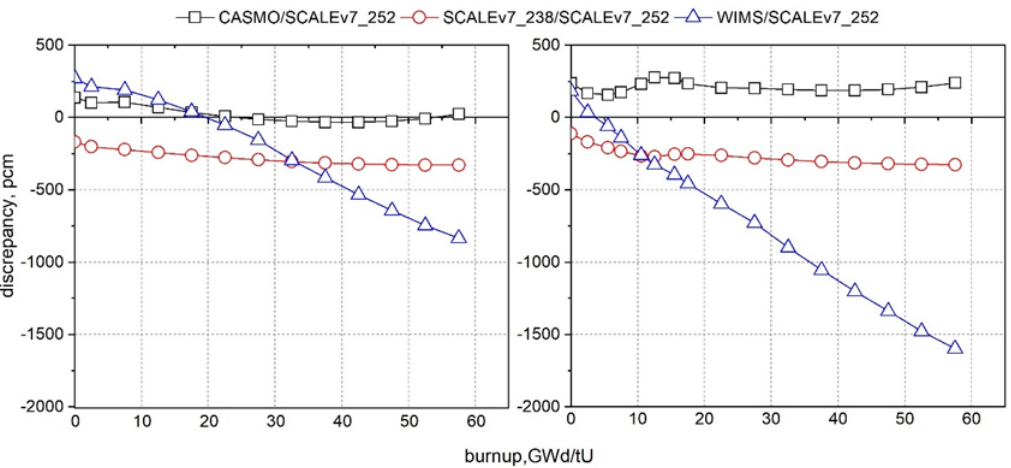
Figure 4. Difference in k inf between SCALE-6.2, WIMS-10A and CASMO5 as a function of burnup for BWR pin-cell ( left ) and BWR 3 by 3 array with gadolinia rod ( right ) models.